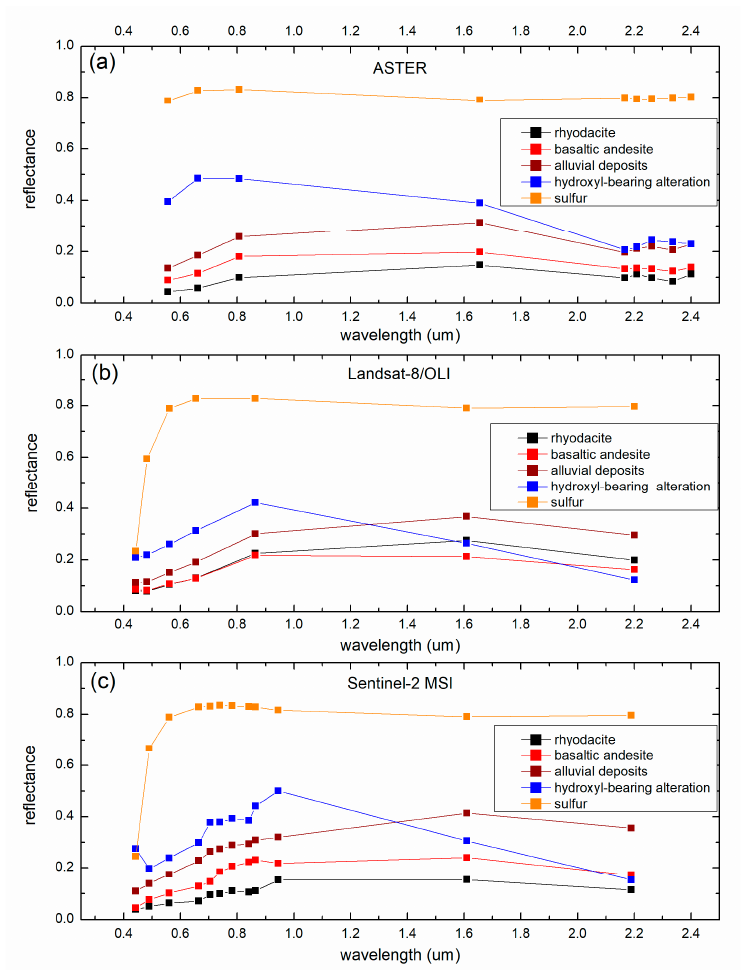
Figure 4. Plot of the five endmembers used in the SU procedure for ( a ) ASTER, ( b ) Landsat-8/OLI, and ( c ) Sentinel-2 MSI datasets.